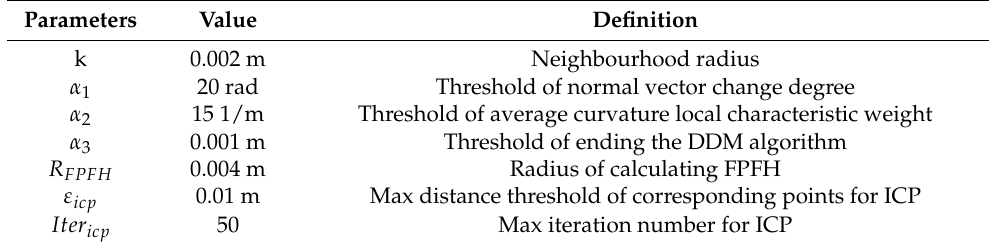
Table 2. All parameters of the proposed